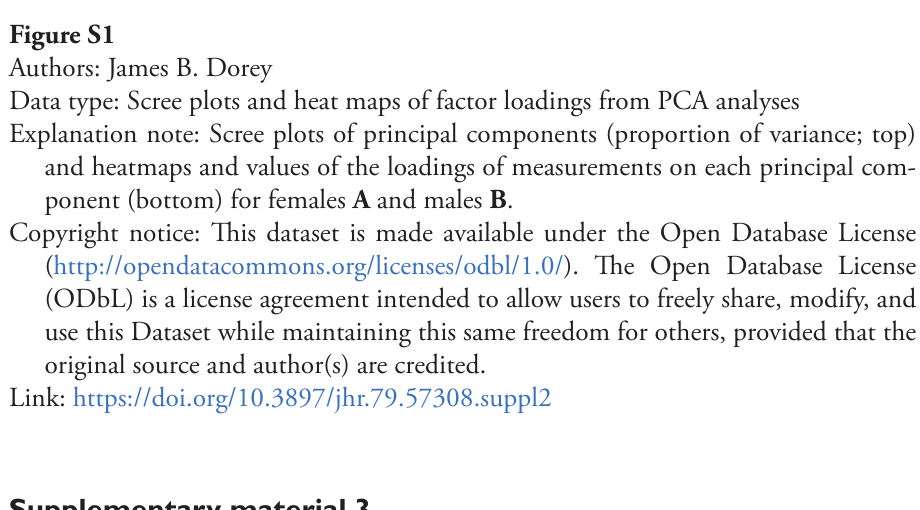
Data type: Figure of PCA plots Explanation note: Principal components one and two of female A and male B and principal components three and four of female C and male D bees where labels indicate species and colour indicates known foraging behaviour (diurnal: red, fac- ultative: green and low-light: red). Measurements are defined in Fig. 1. These plots indicate relative factor loadings for the morphological traits as vectors from the